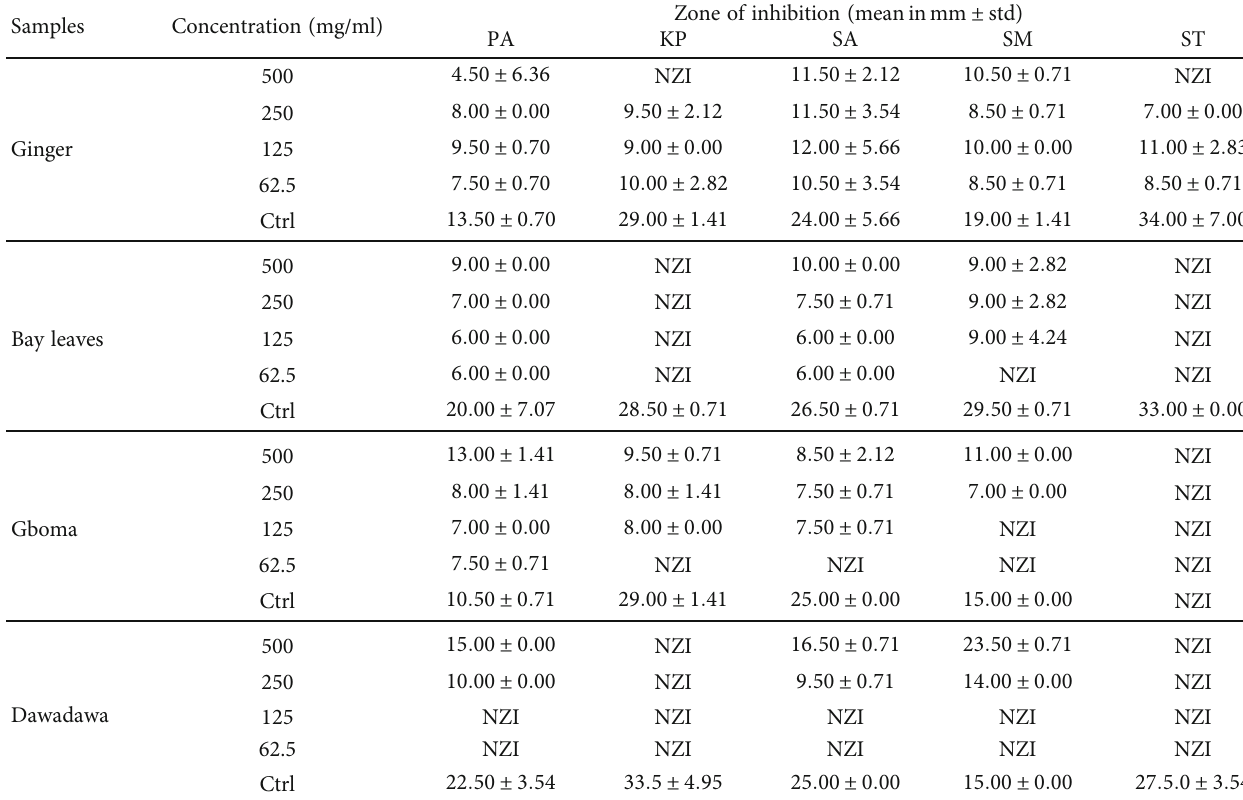
Table 4: Pooled data of antimicrobial activities of spices and herbs against microorganisms. Samples